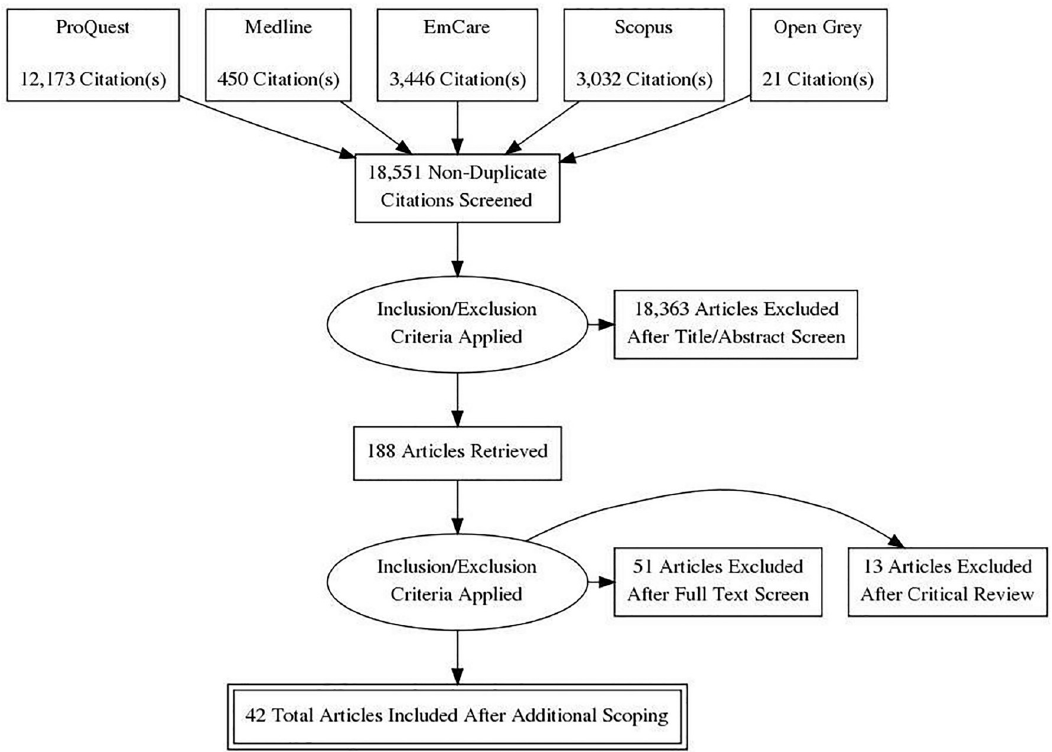
Fig 1. PRISMA diagram outlining the process of electronic database and other